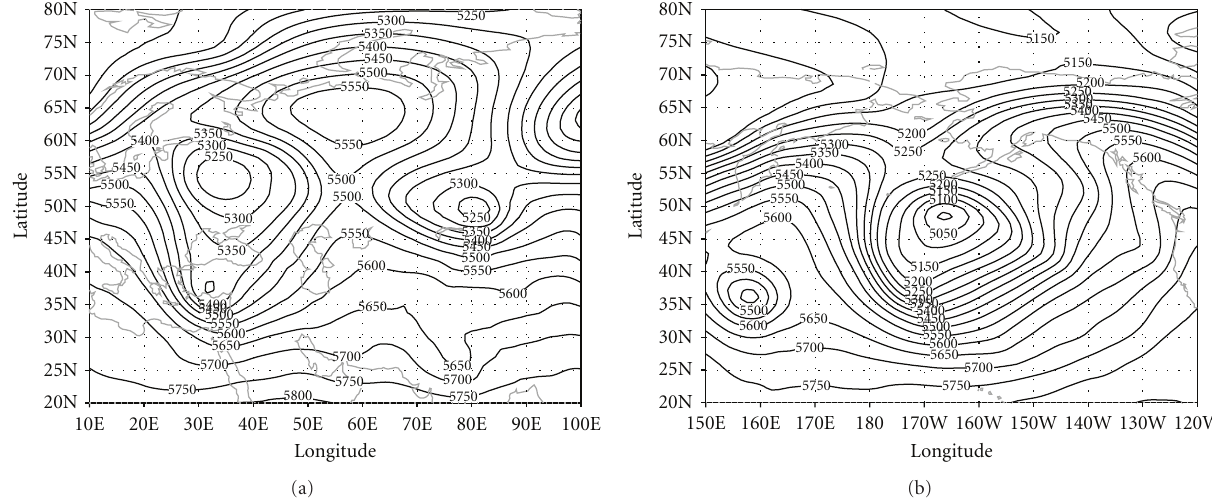
Figure 12: 500hPa Geopotential heights for (a) fully developed blocking Feb. 20th 00UTC 1990, (b) cut-o ff low Feb. 23rd 00UTC 1990.